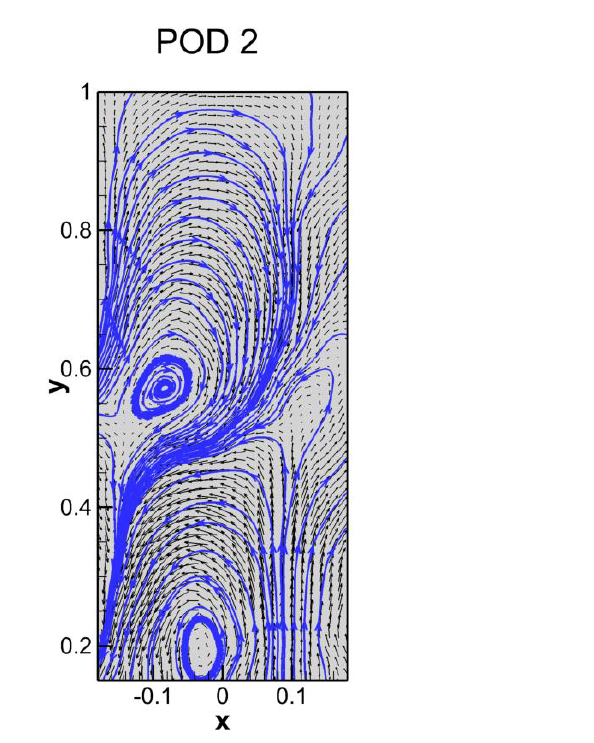
Fig. 11. Velocity POD mode No. 2, 2.6% TKE.